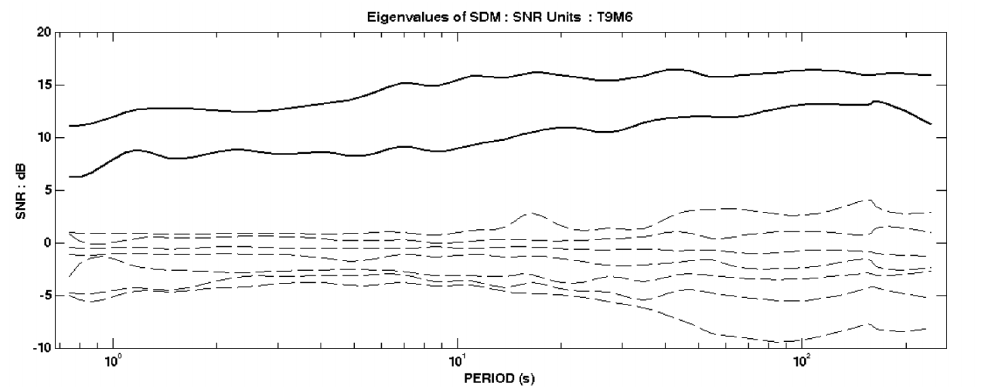
Fig. 7d. Eigenvalues of SDM for TR site: the two dominant eigenvalues are plotted with solid